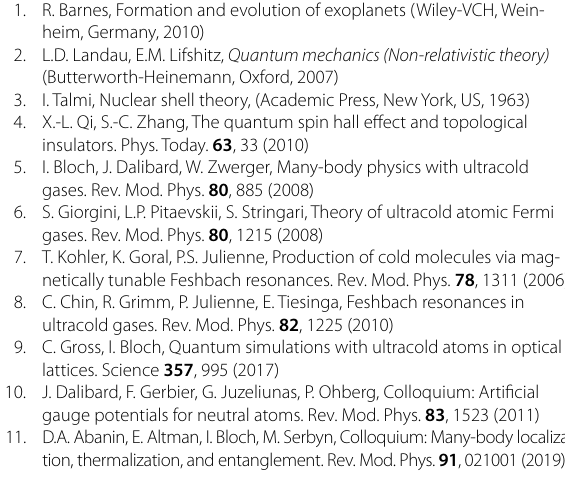
Fig. 18 The ground‑state phase diagram of a SOAM‑coupled condensate. Three quantum phases are characterized by QAMs l z curves denote the phase boundaries predicted by the mean‑field theory, which are experimentally confirmed. The background color denotes the spin